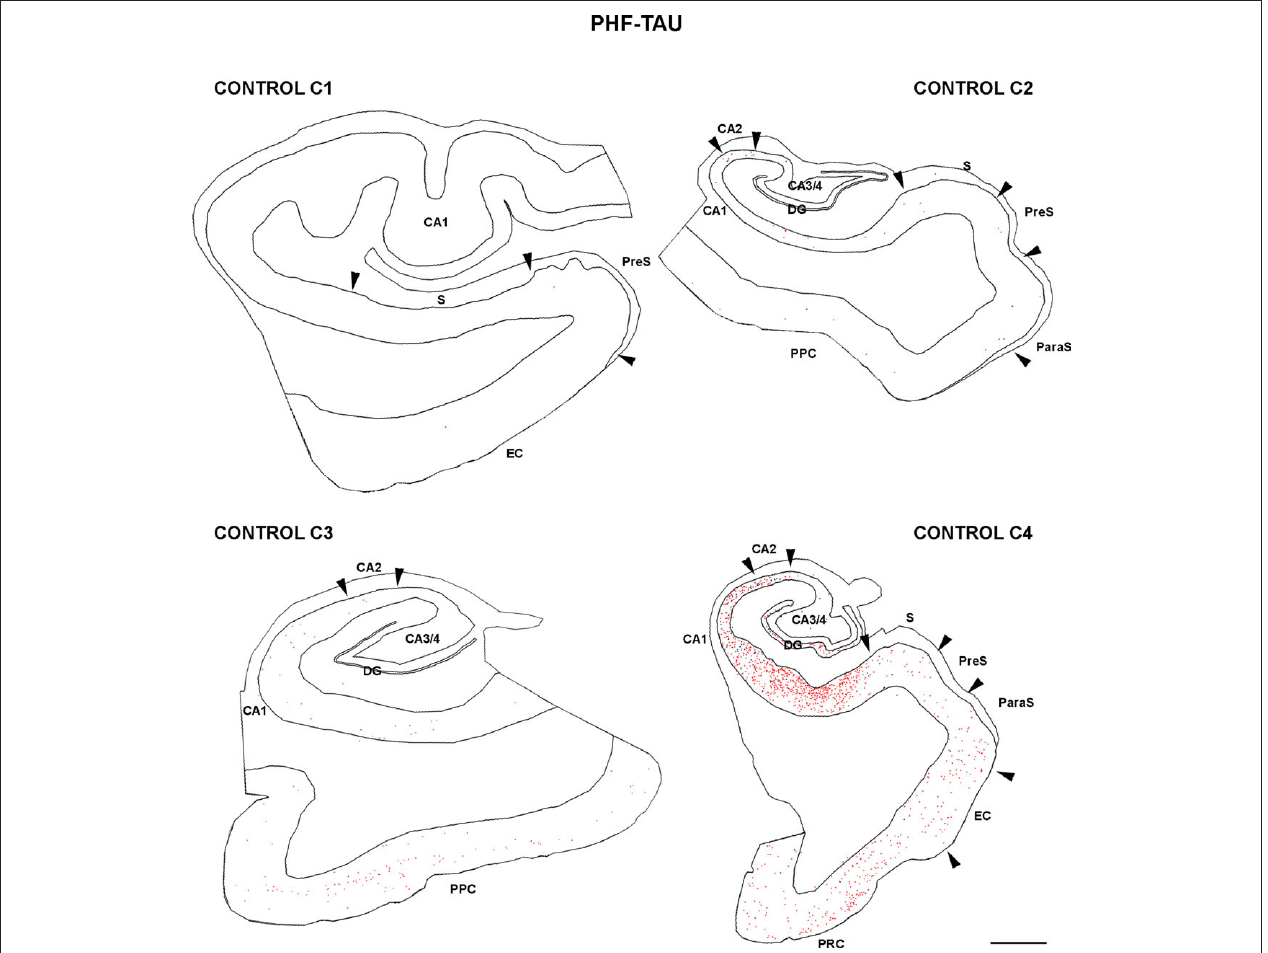
formation and adjacent cortex from control cases. Borders between the different cytoarchitectonic regions are indicated by arrowheads. Scale bar: 1,000 μm. Abbreviations as in Figure 5